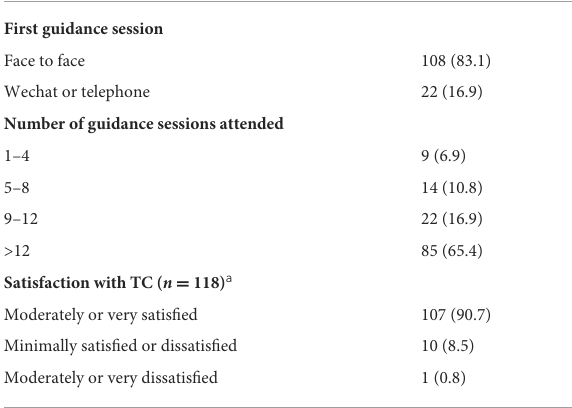
TABLE 2 Mode and attendance at TC sessions and satisfaction with TC ( N =